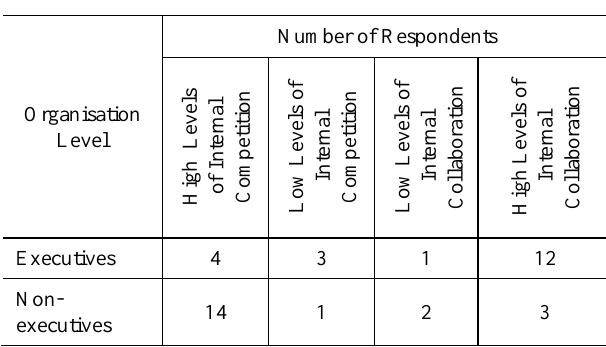
Table 7: Competition and collaboration at different